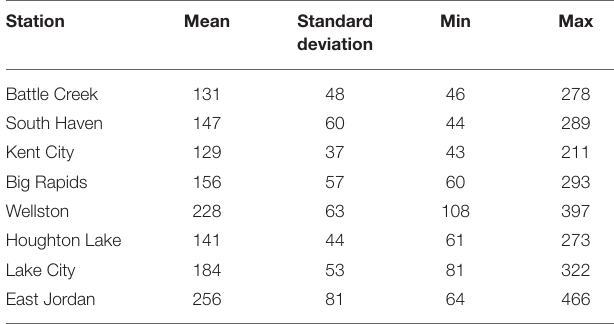
TABLE 1 | Basic statistics of annual total snowfall (cm) at the stations for the period of